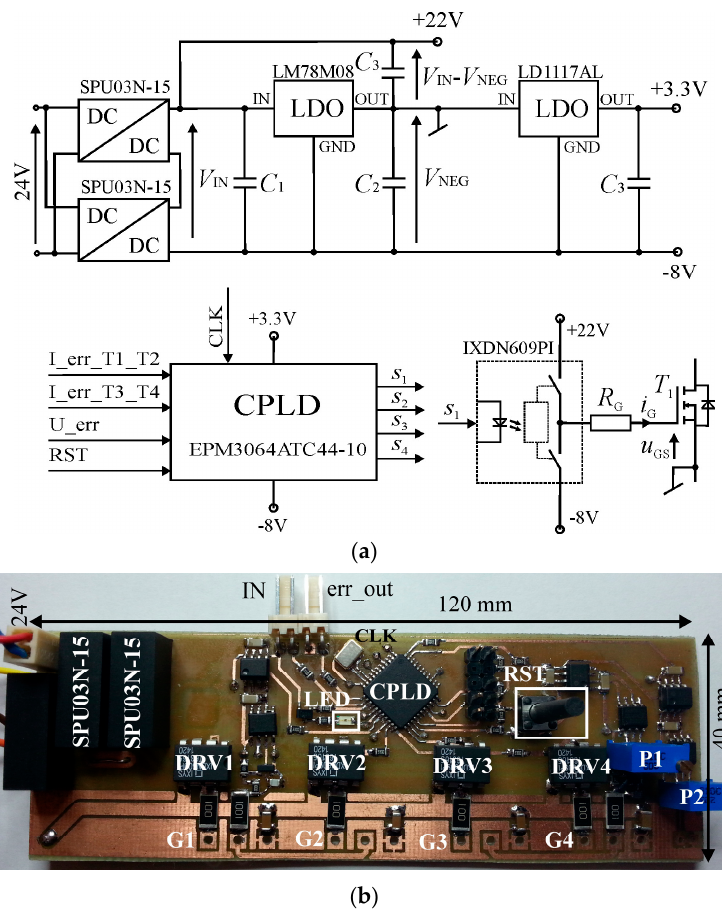
Figure 8. The gate driver for the interleaved DC-DC converter: ( a ) scheme and ( b ) photo of the prototype. According to manufacturer recommendations, the positive supply voltage of the gate drivers is set to 22 V, while negative bias equals − 8 V. In order to ensure asymmetric division of the 30 V supply voltage, a special circuit with a Low-Dropout (LDO) regulator was designed. Outputs of the DC-DC converters (two SPU03N-15 (MEAN WELL, New Taipei City, Taiwan) from Mean Well connected in series) are connected to the voltage regulator (LM78M08) (STMicroelectronics, Switzerland,